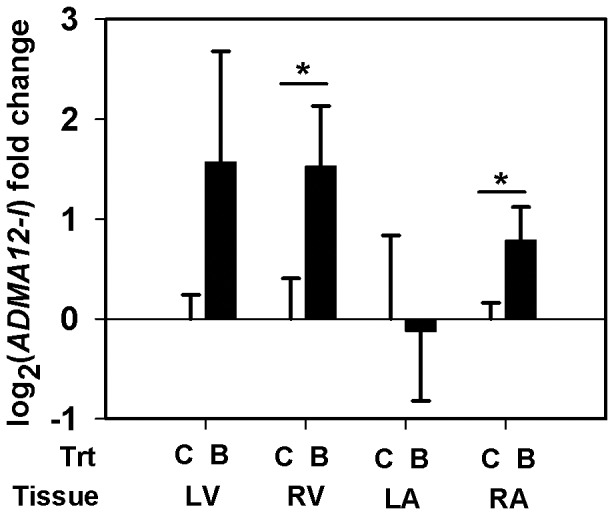
Expression changes in Adam12-l mRNA.Real-time PCR quantification of the long isoform of A Disintegrin And Metalloprotease (Adam12-l) expression in the left ventricle (LV), right ventricle (RV), left atrium (LA) and the right atrium (RA) of rhesus monkey (Macaca mulatta) fetuses at birth. Fetuses were exposed maternally to a 400 µg/Kg. body weight of BPA dose (B) or 150 µL ethanol (C) during late gestation (LG, days 100±2–term). Data were analyzed by tissue and bars represent the mean ± S.E.M. of the log2 (fold change). A two sample t-test was performed to identify significant BPA effects and a two-tailed p≤0.05 was considered statistically significant. Asterisk (*) indicate significantly different groups.